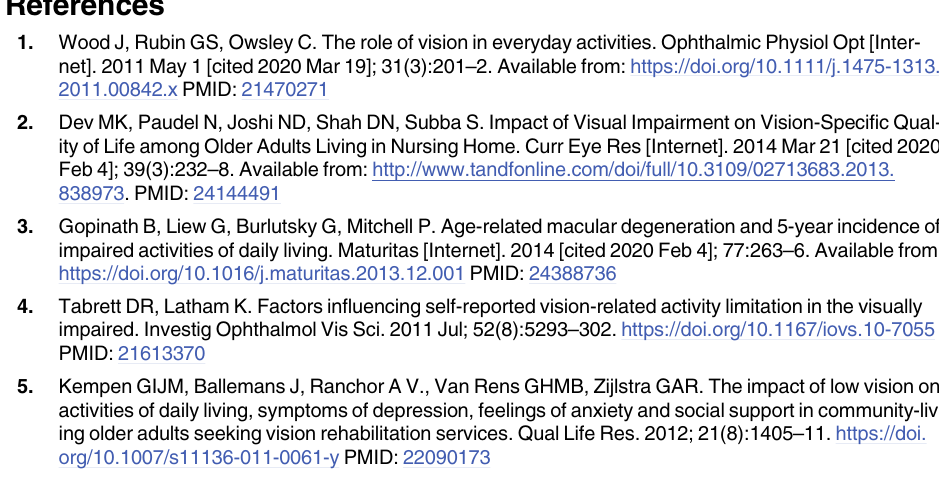
S3 Table. Grouped means (sd) [min,max] for tracking data. Showing participants with nor- mal VA (Normal); participants with high visual acuity (VA > 0.2 logMAR in with eye; High); Those with a large interocular difference (a difference in VA > 0.2 logMAR between their eyes; Different). pPA–Penalised Path Accuracy